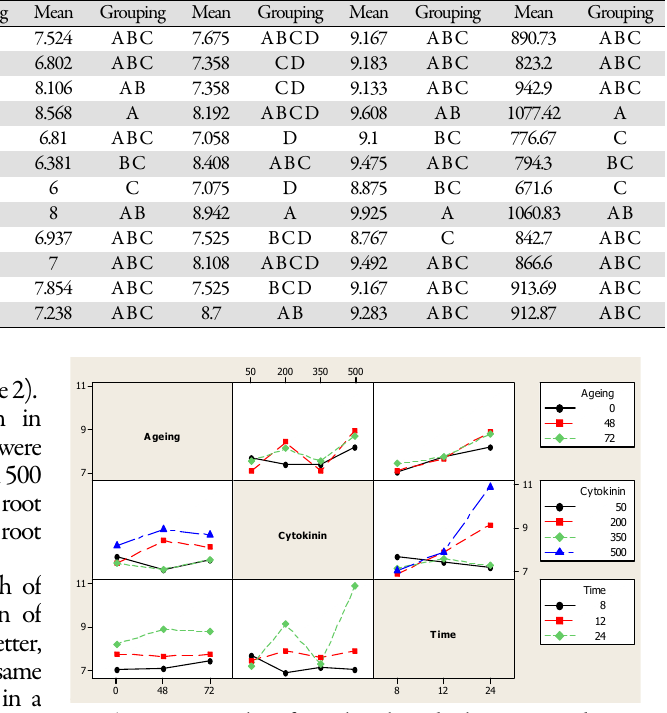
Fig. 4. Interaction plot of root length under hormone seed priming and ageing